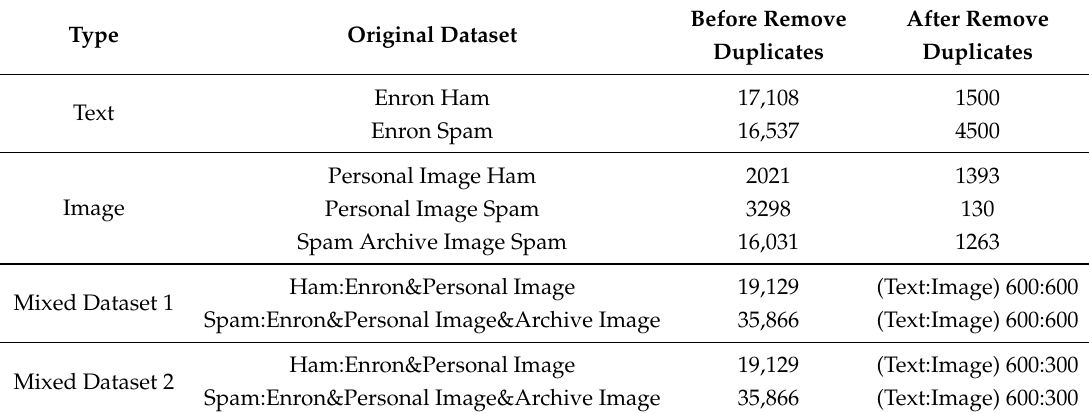
Table 5. Datasets used in